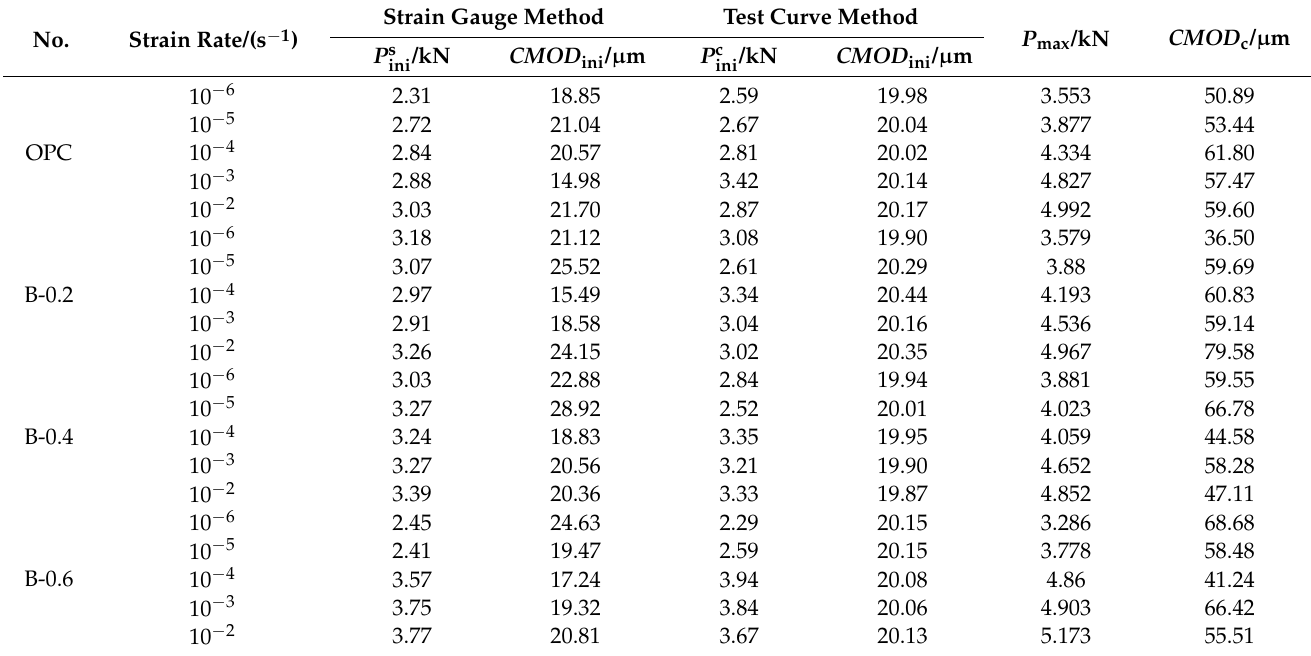
Table 3. Statistical table of fracture loads.